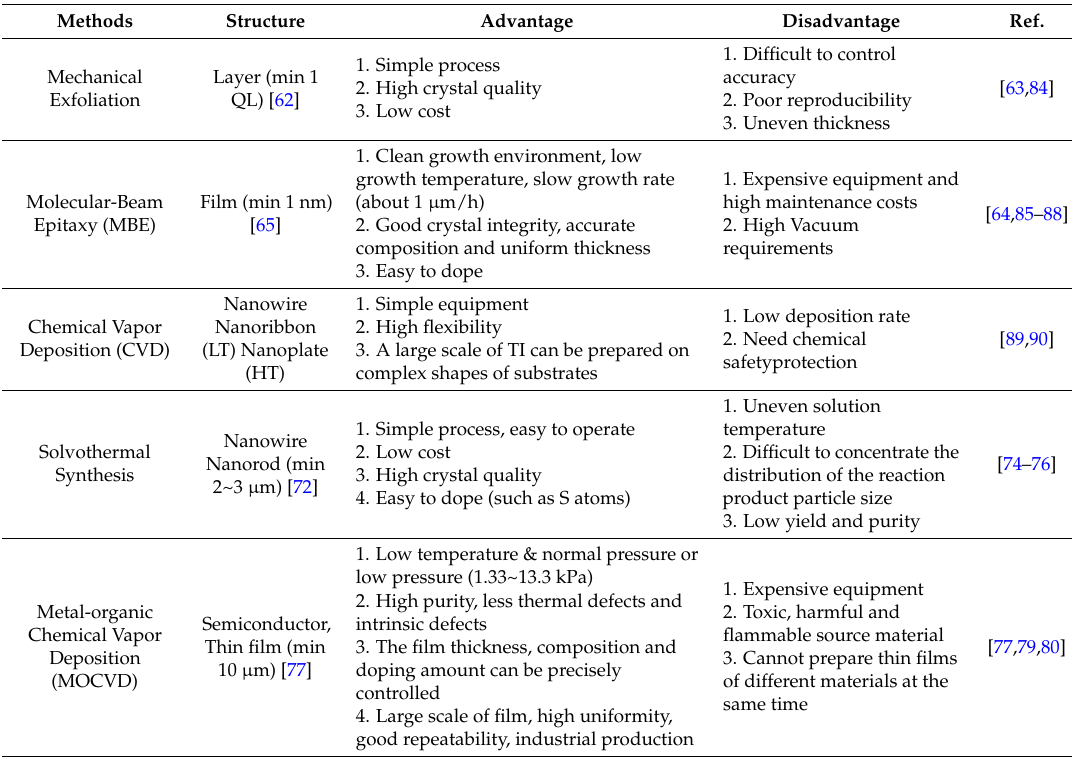
Table 2. Comparison of different preparation